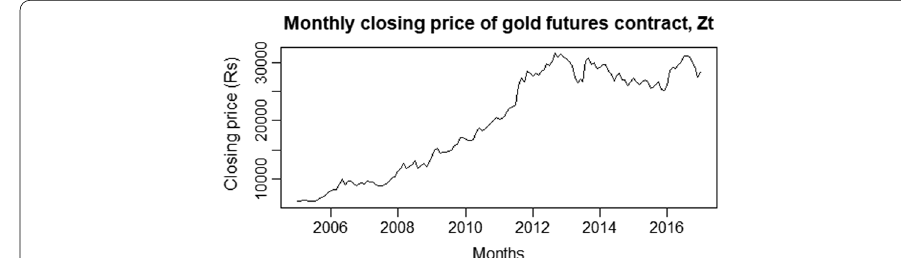
Fig. 1 Plot of the monthly price series, Z t